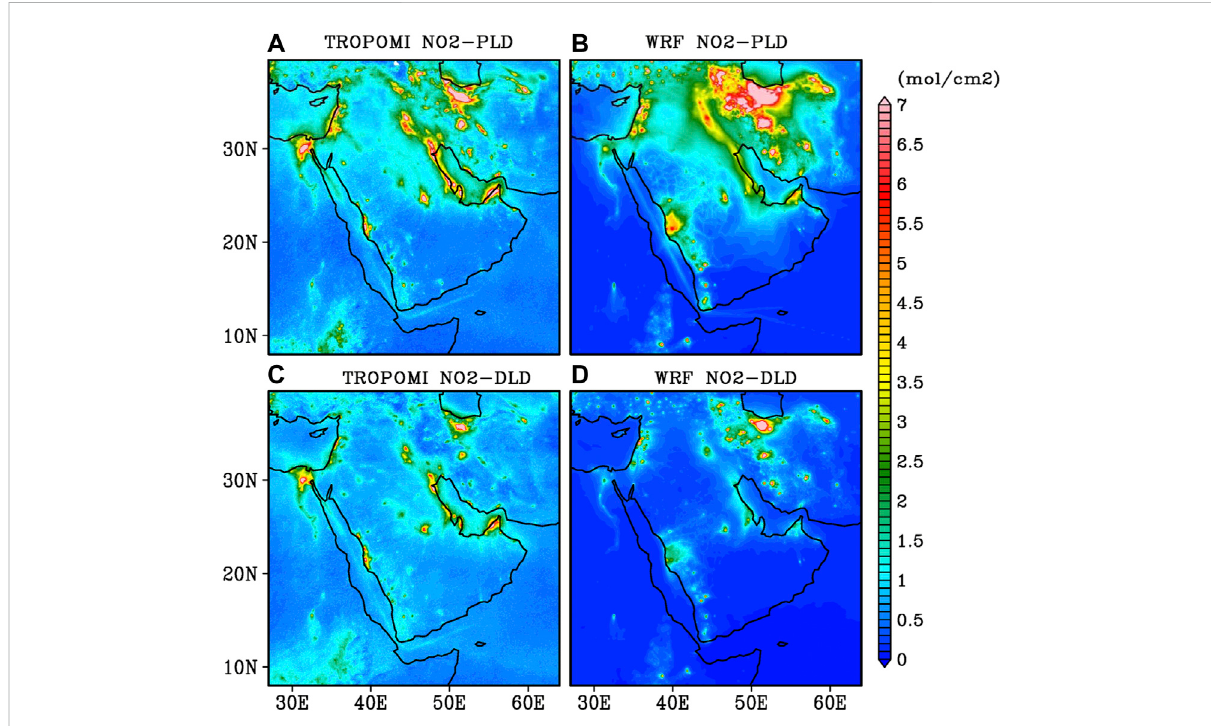
FIGURE 3 Time averaged spatial distribution of NO 2 as inferred from TROPOMI during (A) PLD and (C) DLD periods. (B, D) are the same as (A, C) but from WRF-Chem